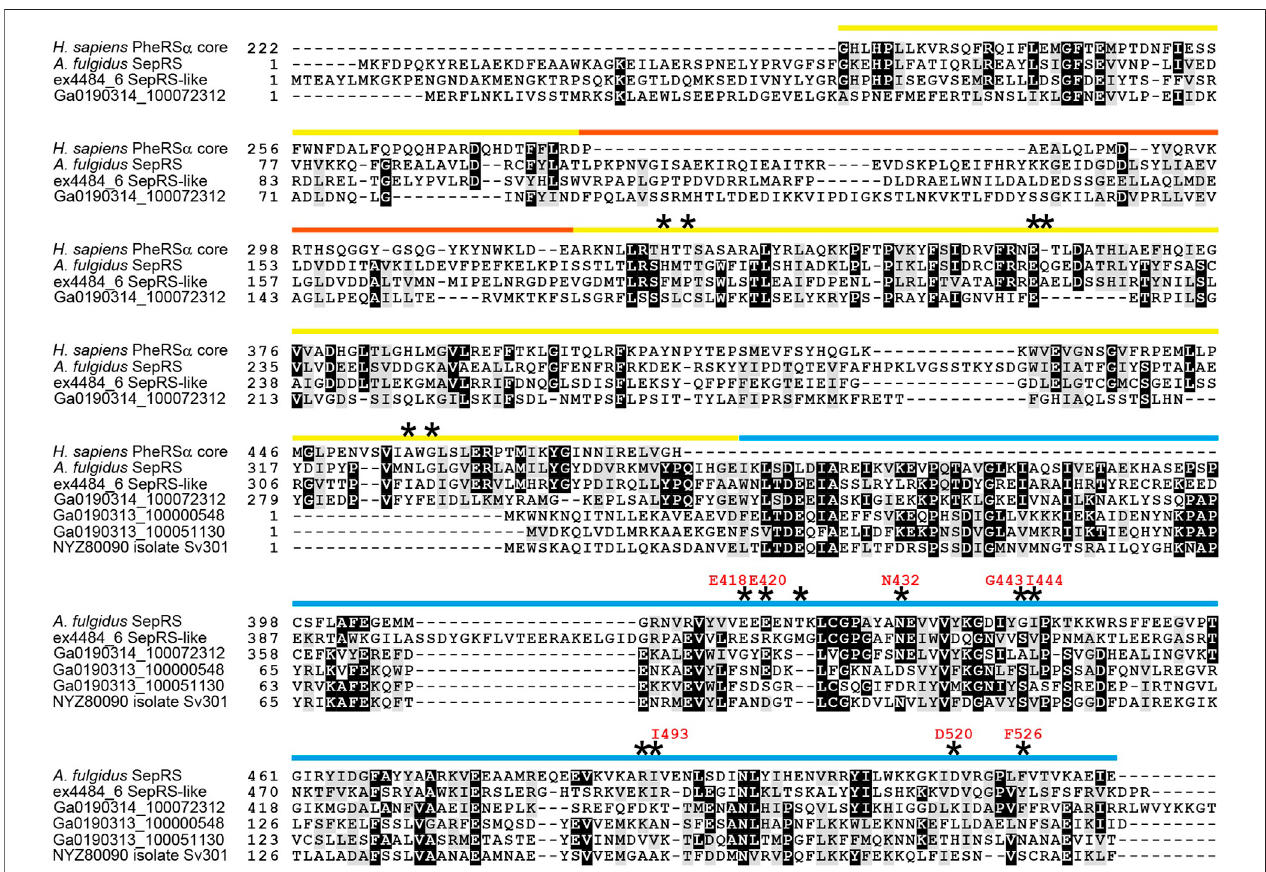
FIGURE 8 | Characterization of degenerated SepRS homologs from Alv-FOS5/pISA35 groups of Micrarchaeota archaea. Multiple sequence alignment of SepRS homologs with the catalytic core of Homo sapiens PheRS (residues 222-480). Interesting mutations are indicated with stars. The amino acid residues of A. fulgidus SepRSwhichareimportantforanticodonlooprecognitionareindicatedwithredcharacters.Thecolorbarsrepresentthedomainstructureandfollowthesamescheme as in Figure 3 , with the yellow bar denoting the catalytic domain, the orange bar denoting the inserted domain, and the blue bar denoting the anticodon binding domain. The full-length SepRS homolog belongs to a putative Alv-FOS5-group Micrarchaeota archaeon (Ga0190314_1000723, Ga0190313_1000196, Ga0190313_1000256, Ga0190313_1002238), while the small homologs belong to pISA35-group Micrarchaeota archaea (Ga0190313_1000005, Ga0190313_1000009, Ga0190313_1000511, Ga0190313_1005305) in Guaymas Basin hydrothermal vent metagenomes (4870-07-11-12_MG and 4870-07-10- 11_MG) and in a freshwater sediment metagenome from Lake Svetloe, Arkhangelsk region (PRJNA644262).